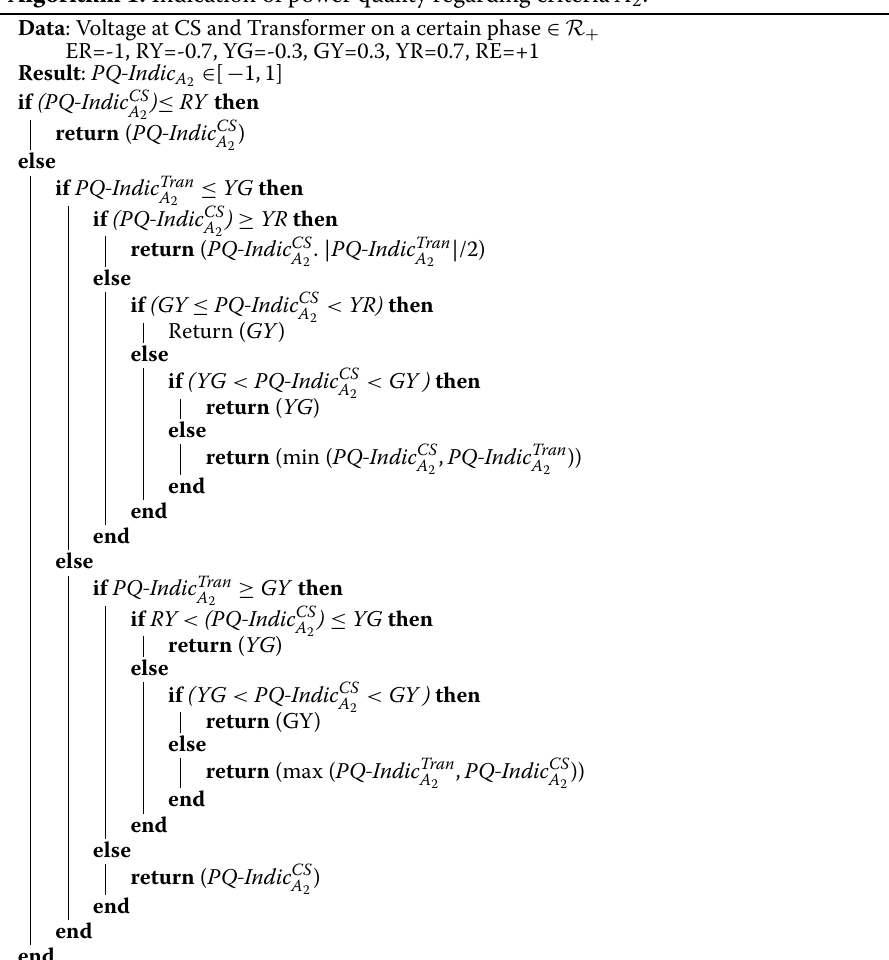
Algorithm 1: Indication of power quality regarding criteria A 2